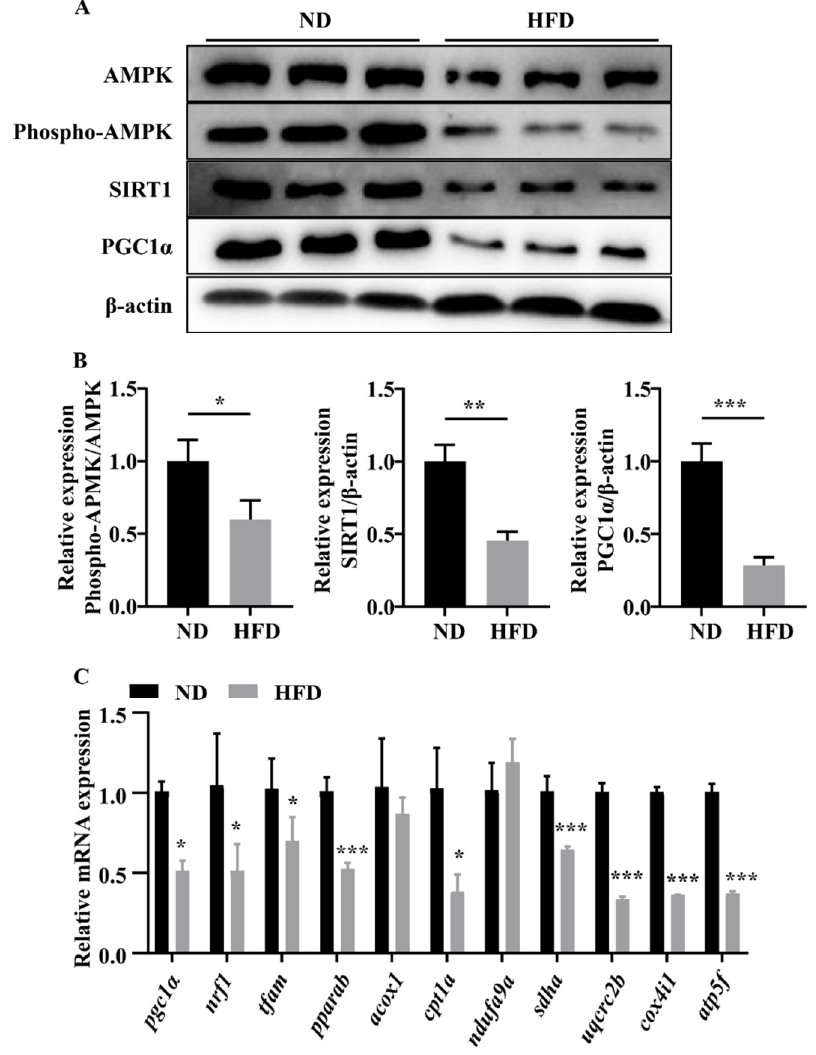
Figure 4. Long-term HFD feeding induced abnormal mitochondrial dysfunction. ( A , B ) Phospho- AMPK, SIRT1, and PGC1α protein levels. ( C ) mRNA expression of genes related to mitochondrial biogenesis, fatty oxidation, and ETC complexes subunits. *, p < 0.05, **, p < 0.01, ***, p < 0.001. Data represent means, and error bars represent standard errors of the means. ND, normal diet; HFD, high-fat diet; ETC, electron transport chain.